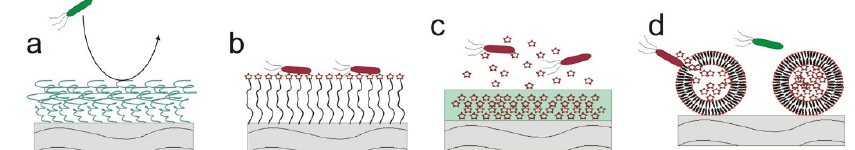
Figure 1. Classes of antibacterial coatings: ( a ) repelling bacterial attachment or biofilm development; ( b ) contact killing; ( c ) releasing of antibacterial agents; and ( d ) stimuli responsive release in the presence of bacteria.